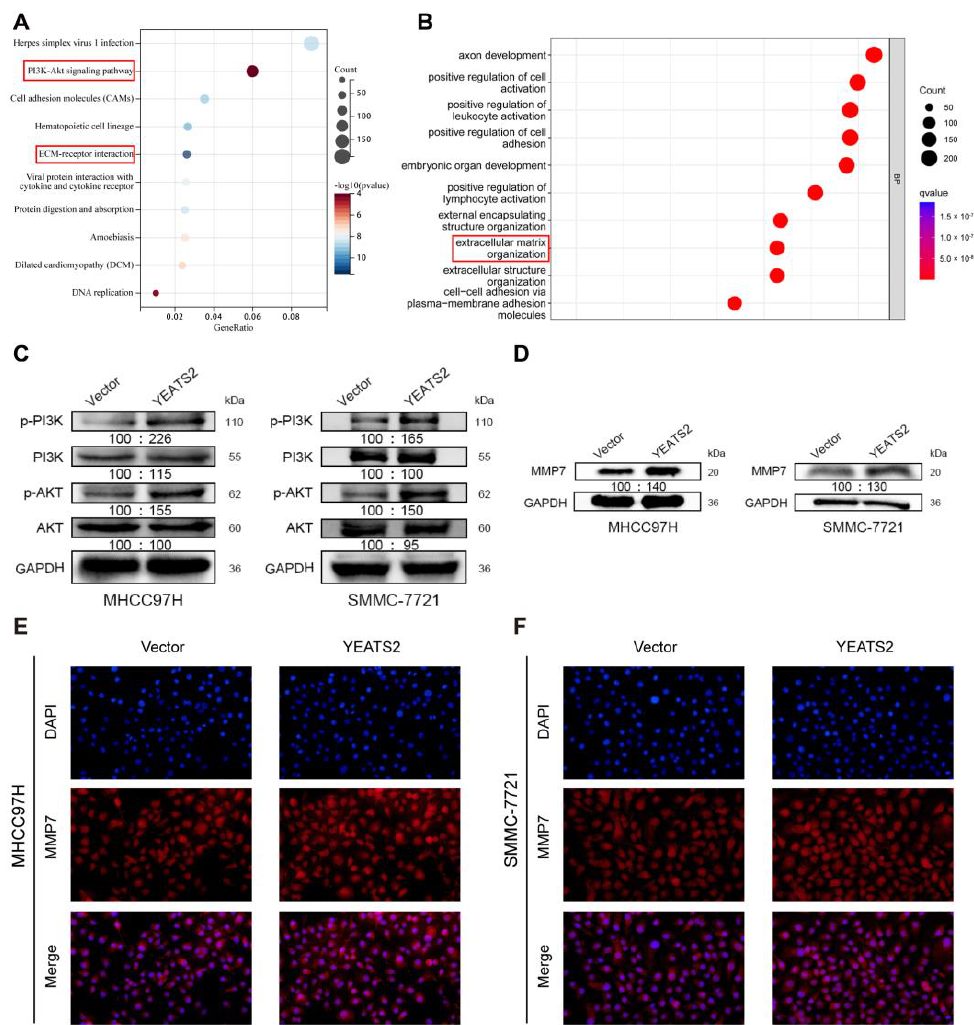
Figure 5. YEATS2 activates PI3K/AKT signaling pathway and remodels extracellular matrix. ( A , B ) GO and KEGG pathway enrichment analysis results indicated that YEATS2 participates in the progression of liver cancer through PI3K/AKT pathway and regulating extracellular matrix. ( C ) Western blot analysis of p-PI3K and p-AKT expression. ( D ) Western blot analysis of MMP7 expression. ( E , F ) Detection of MMP7 expression in cells using immunofluorescence.